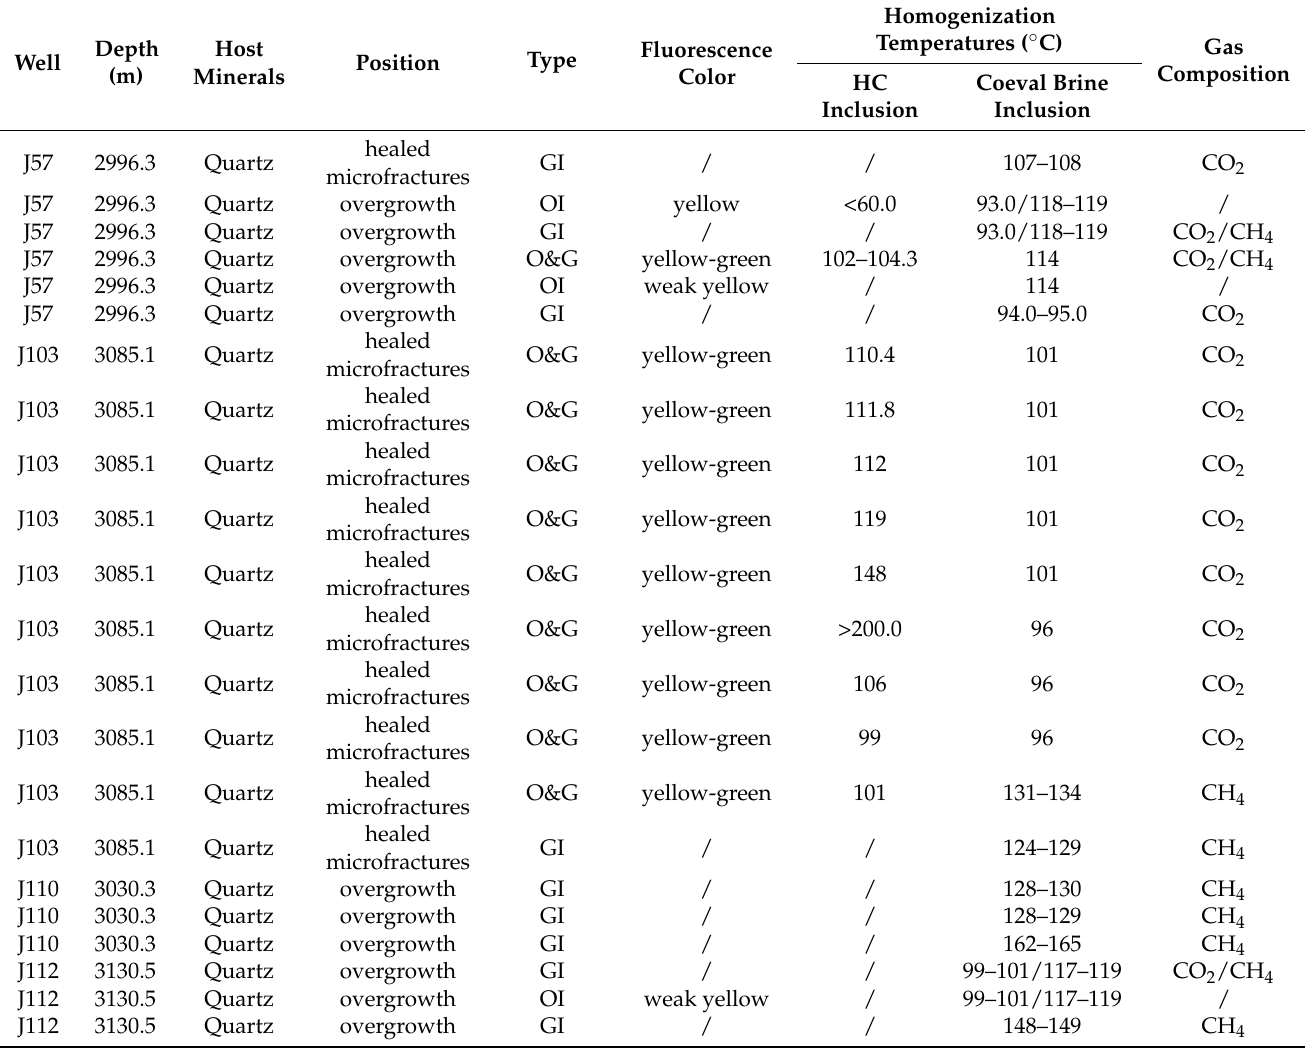
Table 3. Typical fluid inclusions characteristic of the Lower Shihezi Formation